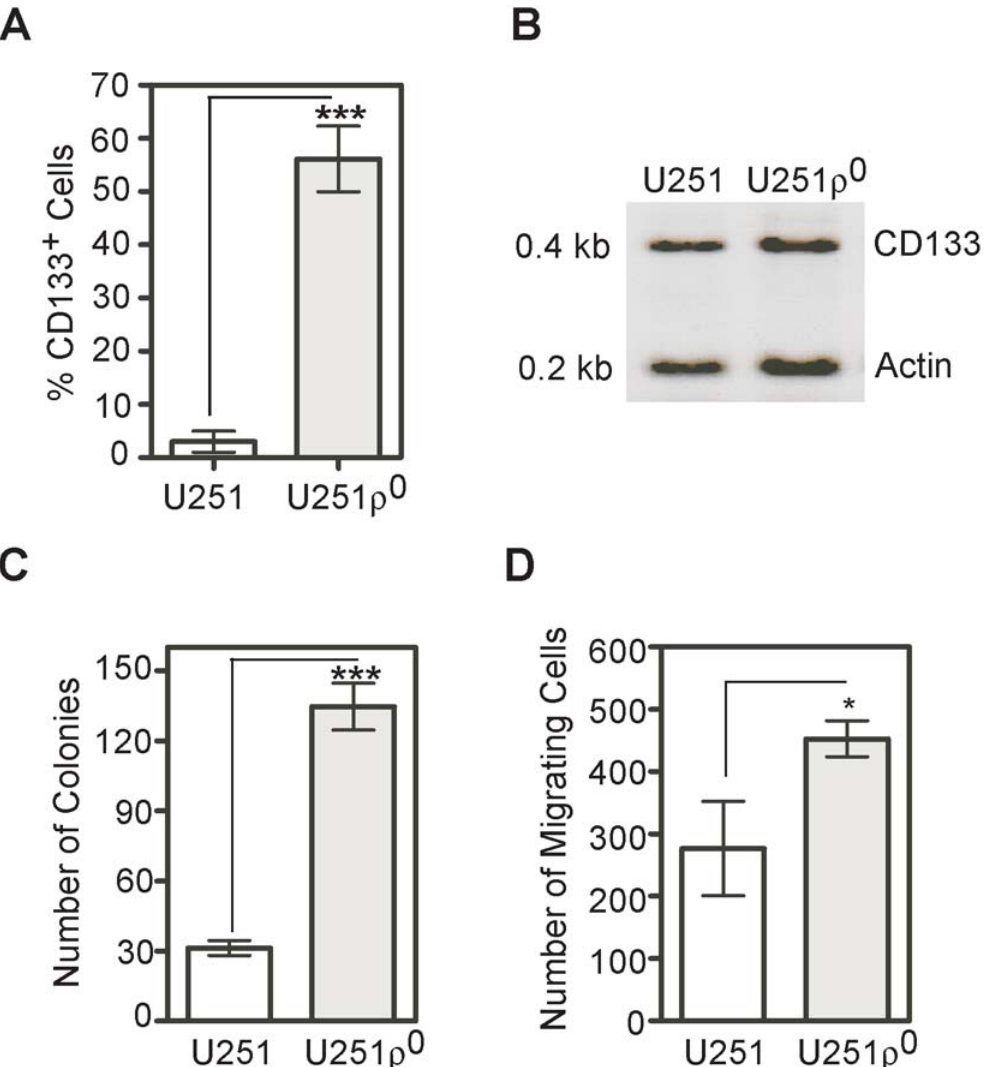
Figure 4. Anchorage-independent, invasion and CD133 expression in r 0 glioma cells. A ) Flow cytometry determination of the percentage of CD133 expressing parental and r 0 cells. Results are given as means 6 SD of 5 separate experiments. B) RT-PCR detection of CD133 mRNA from U251 and U251 r 0 glioma cells. Electrophoresis resolved amplicons for CD133 (0.4 kbp) and actin (0.2 kbp) of anticipated sizes. C) Colony formation in soft agar. Results are given as means 6 SD of 3 separate experiments. D) Analysis of invasion into Matrigel 24 h after 5% FCS as chemo-attractant has been added to the lower chamber. *, **, *** represent p , 0.05, p , 0.005 and p , 0.001.